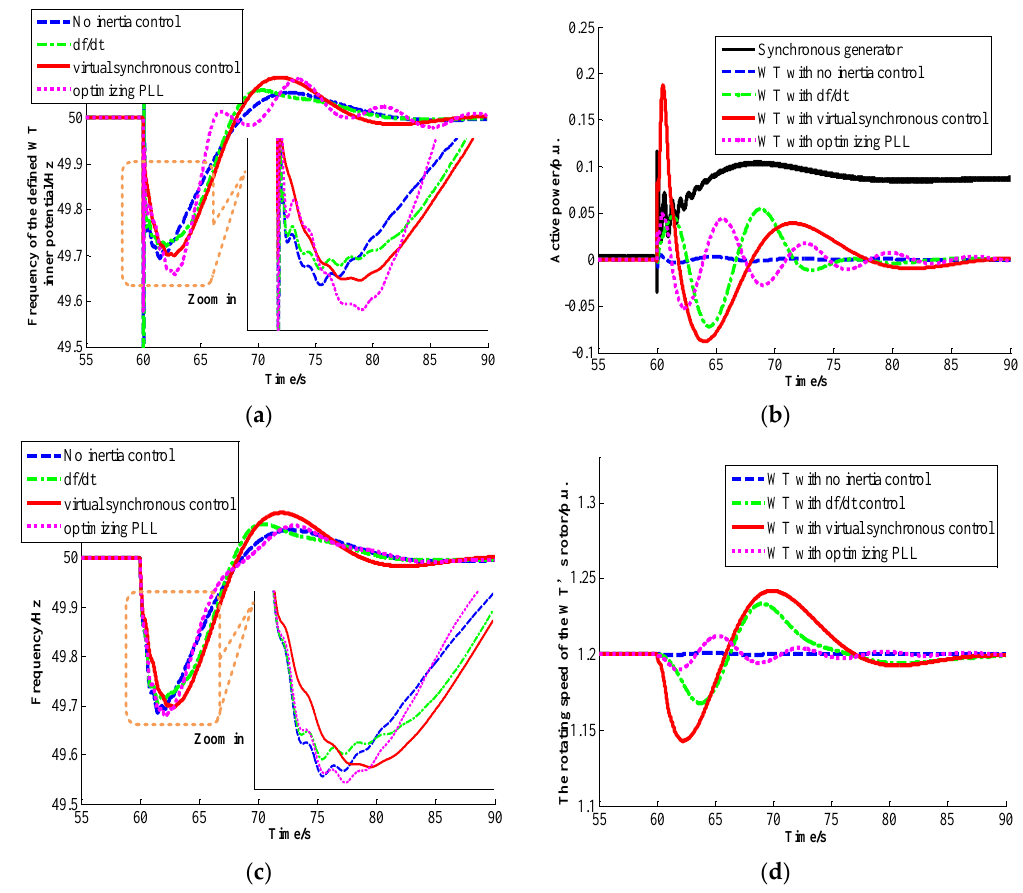
Figure 11. Simulation results of the WT’s inertial response, the grid frequency and the rotating speed of the WT’s rotor. ( a ) The dynamic response of the wind turbine’s defined inner potential with different inertia control methods; ( b ) The inertial response of the wind turbine with different inertia control methods; ( c ) The grid frequency with different inertia control methods; ( d ) The rotating speed of the WT’s rotor with different inertia control methods.